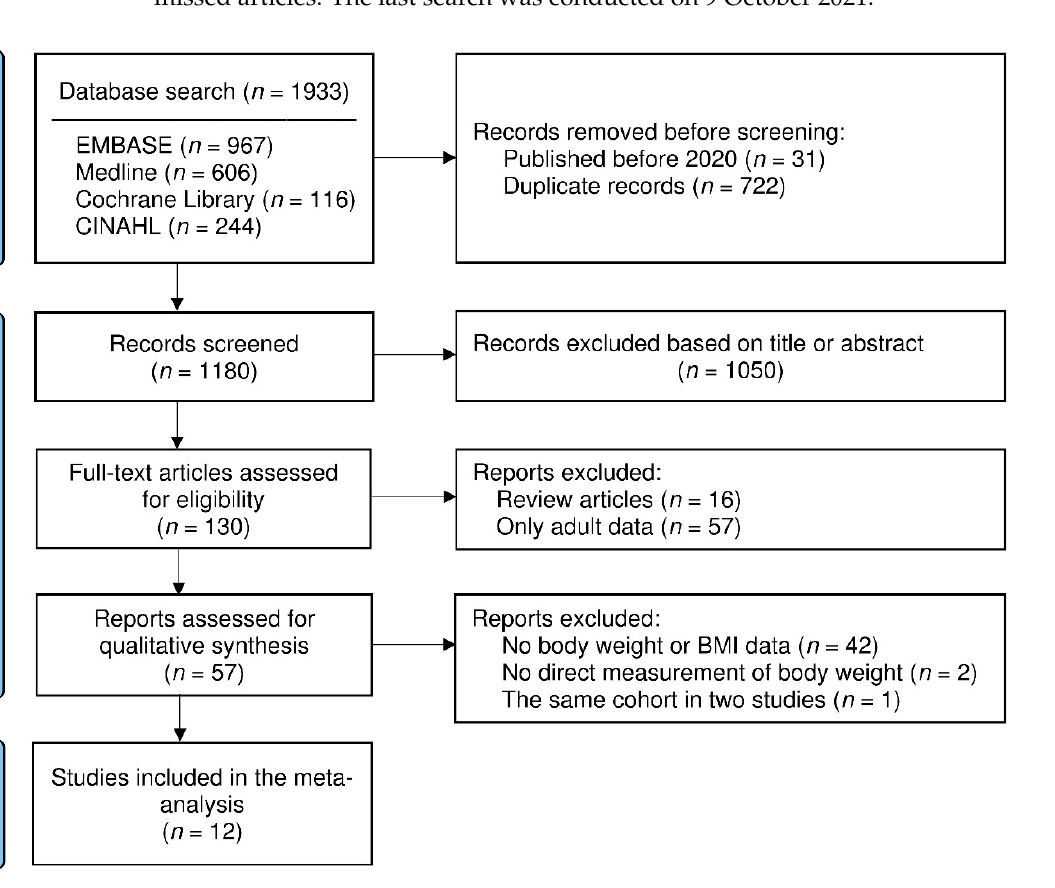
Figure 1. Flow diagram of article identification for inclusion in the qualitative and quantitative analysis.